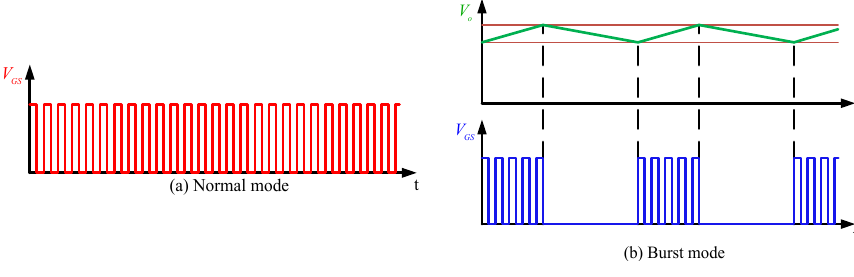
Figure 8. Diagram of burst mode: ( a ) normal mode; and ( b ) burst